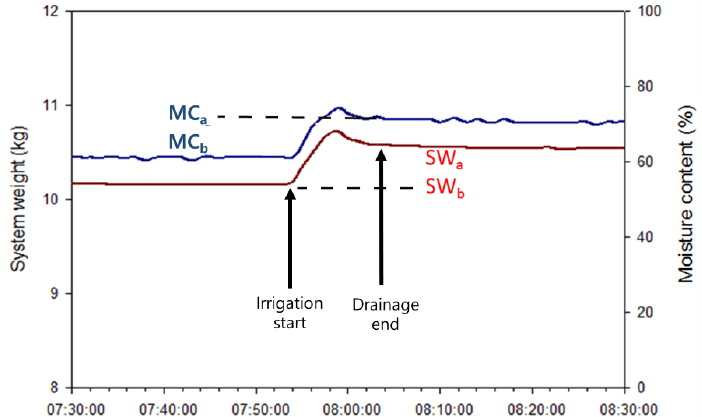
Figure 4. Changes in system weight (SW) and moisture content (MC) measured by load cells and frequency domain reflectometry sensors, respectively, before and after the irrigation. Subscripts a and b mean after and before irrigation, respectively.